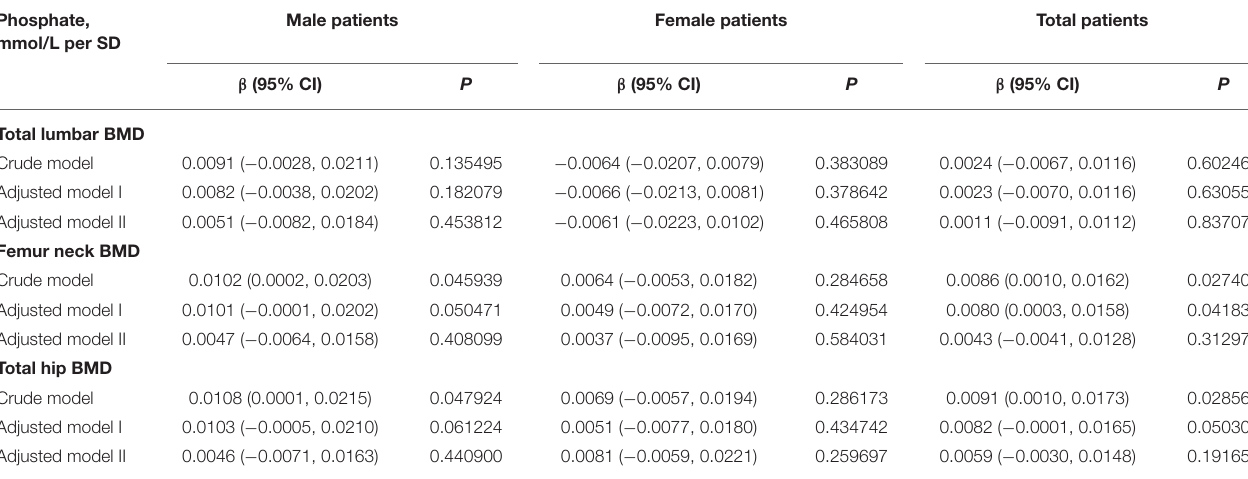
TABLE 2 | Multivariate regression for effect of serum phosphate level on total lumbar, femur neck, and total hip BMD. Phosphate, Male patients Female mmol/L per SD